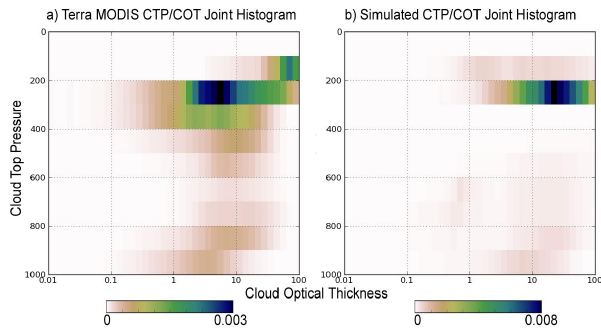
Fig. 8. Joint histograms of cloud optical thickness vs. cloud top pressure for actual (a) and model-based (b) cloud fields covered by Terra MODIS 2013 day 151 at